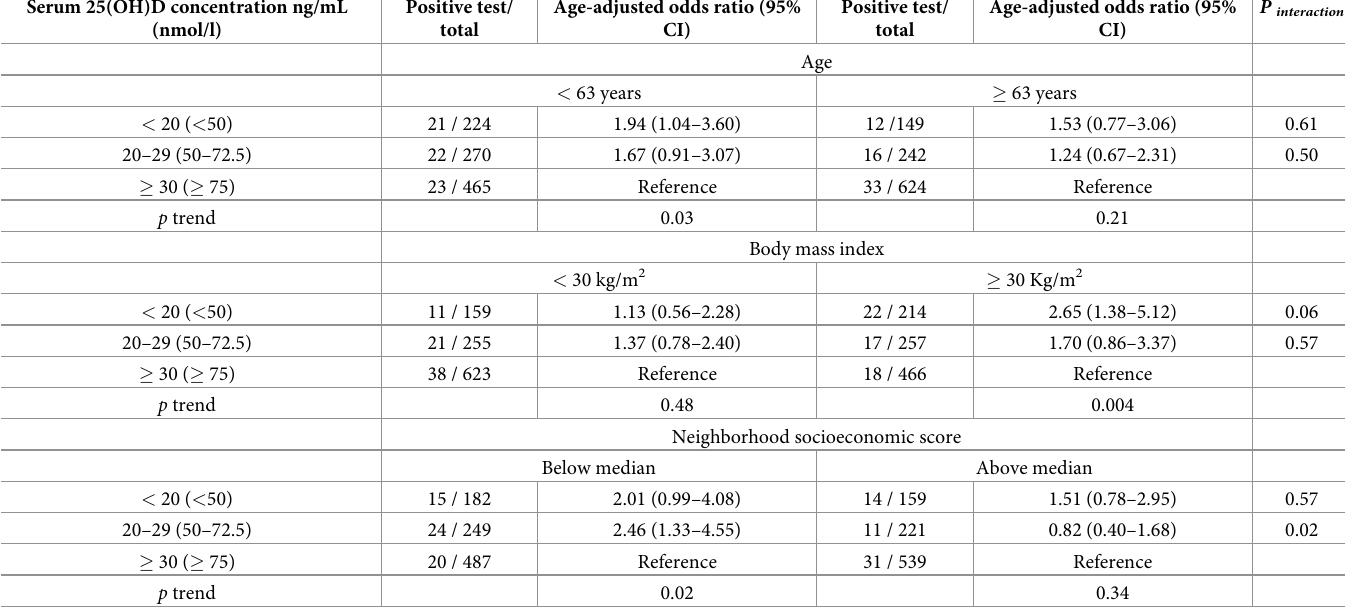
Table 3. Serum 25(OH)D concentration in relation to COVID-19 infection, within strata of age, body mass index, and neighborhood socioeconomic score, Black Women’s Health Study. Serum 25(OH)D concentration ng/mL